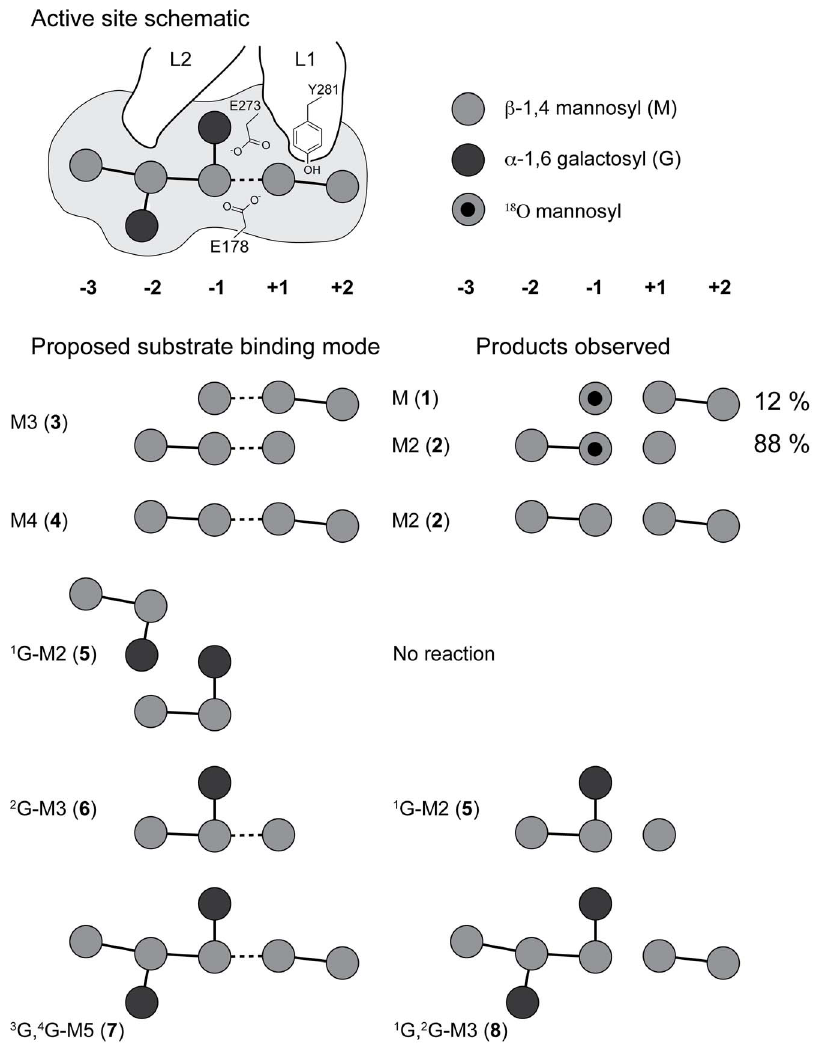
Figure 5. Schematic diagram of the binding subsites of SACTE_2347 correlated with reaction of purified oligomannosides and galactosyl-substituted oligomannosides. The active site schematic shows the positions of sugar binding subsites, the catalytic residues Glu178 and Glu272, and the position of loops L1 and L2. Mannosyl groups (grey circles) and galactosyl groups (black circles) of purified substrates studies are aligned in the 2 3 to + 2 subsites under the schematic of the active site channel. Loop L1 blocks binding of a substituted mannosyl group in either the + 1 of + 2 subsites. The space between L1 and L2 allows placement of a substituted mannosyl group in the 2 1 subsite, while shortened L2 allows placement of a substituted mannosyl group into the 2 2 subsite. All reaction products can be rationalized to arise from hydrolysis of the glycosidic bond between the 2 1 and + 1 subsites after accounting for steric interactions with L1 and L2.